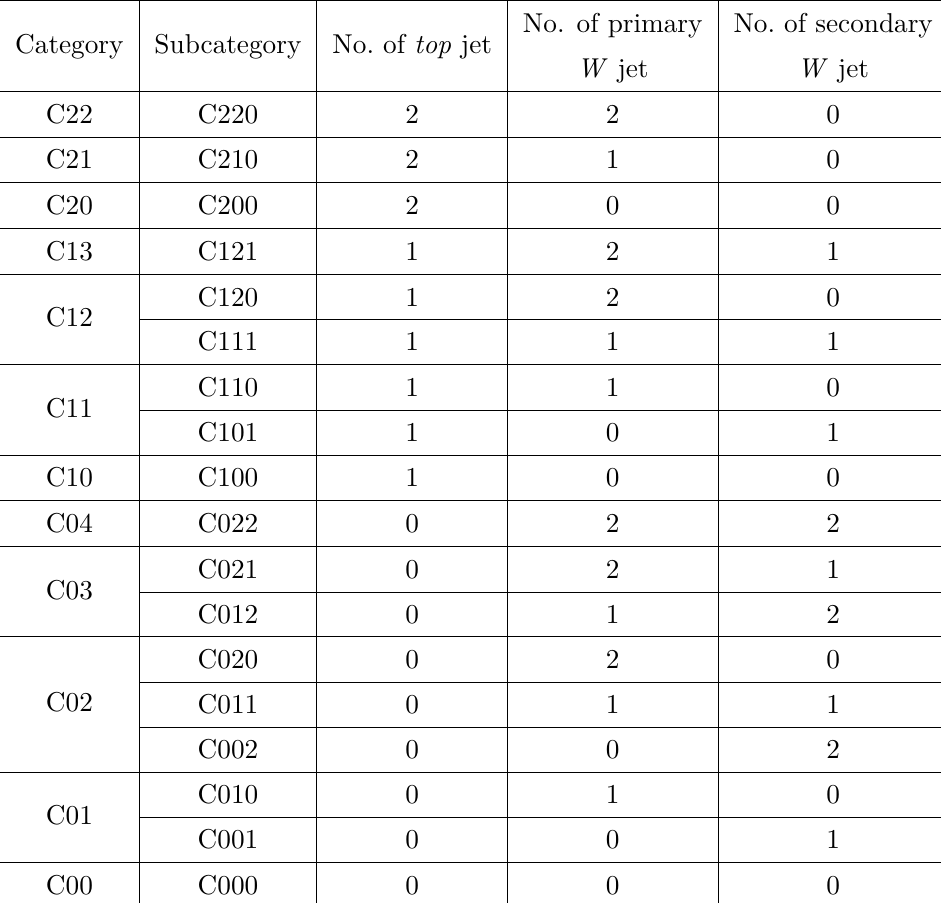
Table 2 . The definitions of the list of categories and subcategories as according to how many fat jets can be reconstructed from the jet